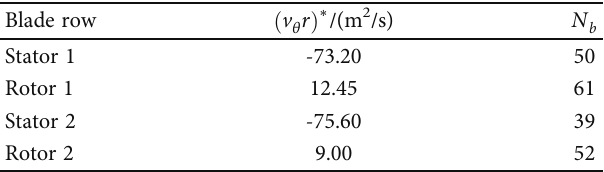
Table 2: Input blade row parameters of the two-stage turbine.